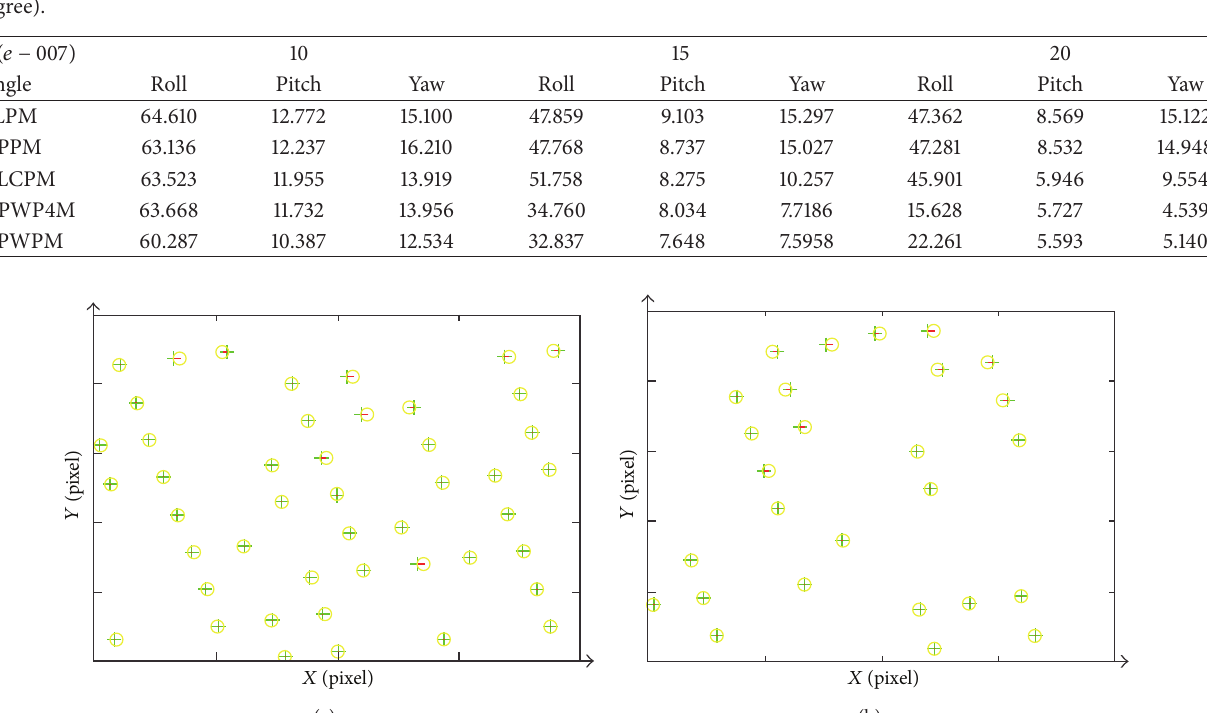
Table 1: The fitting accuracy comparison of the different attitude and orbit modes selecting the different known times on the orbit (unit: degree).